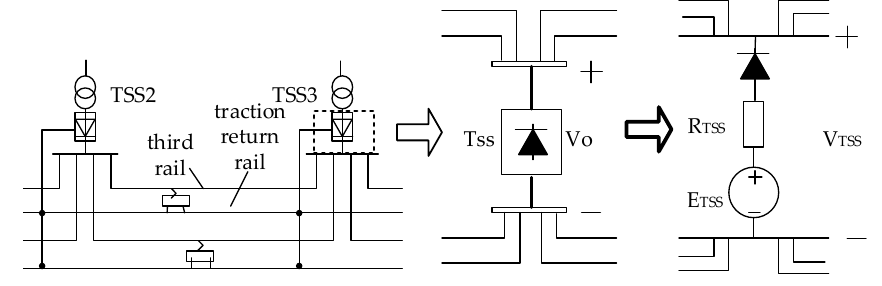
Figure 7. Schematic diagram of rectifier units.